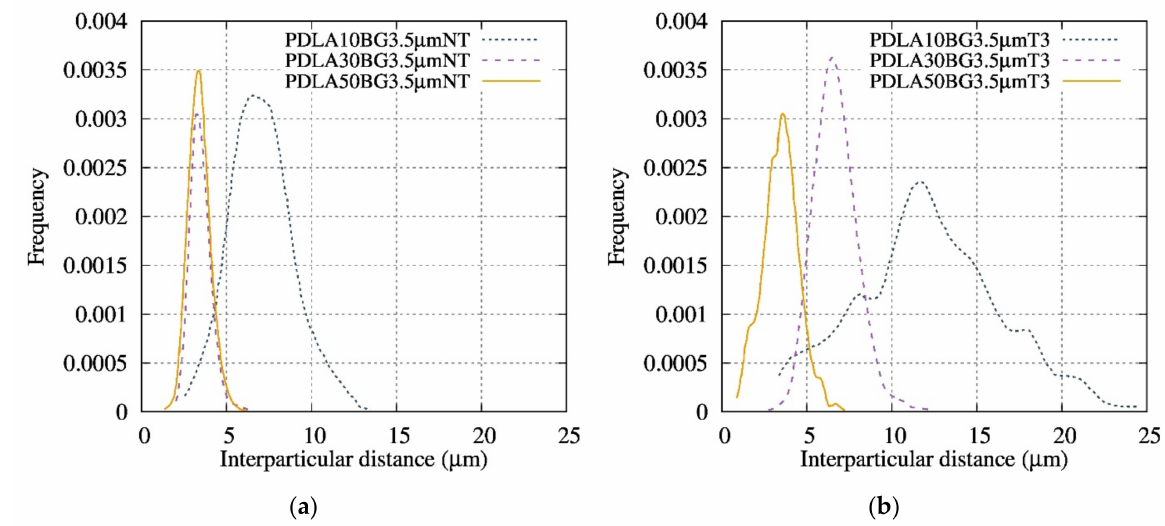
Figure 4. Frequency of inter-particular distances for composites with various contents of ( a ) BG 3.5 µ m NT and ( b ) BG 3.5 µ m T3.